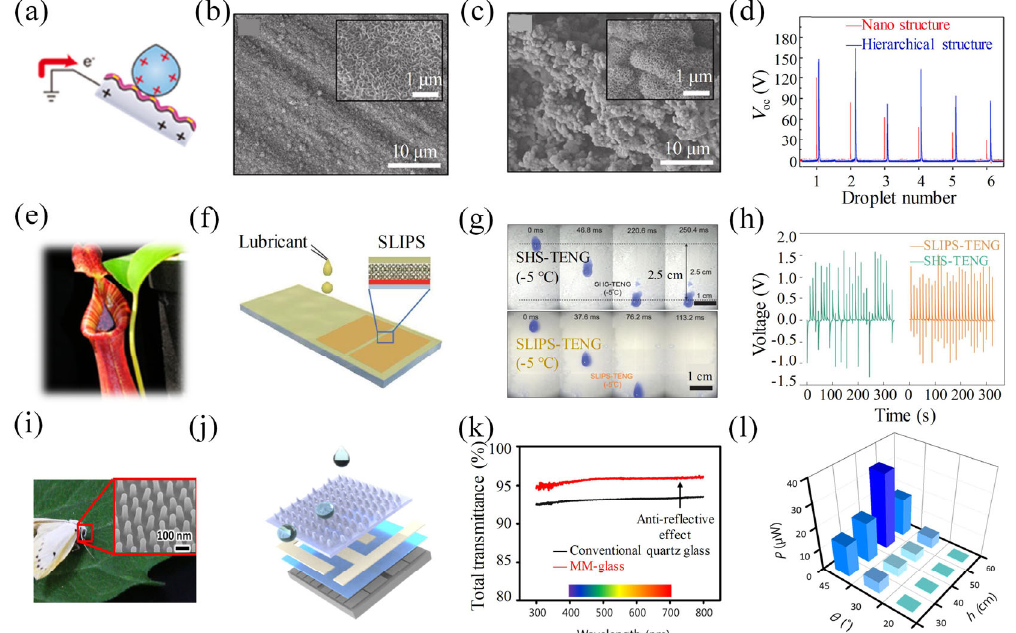
Figure 5 Bio-inspired rainwater-driven electricity generator. (a) Schematic images of a rainwater-driven electricity generator. (b) SEM image of nanostructured superhydrophobic surface of the rainwater-driven electricity generator. (c) SEM image of hierarchically structured superhydrophobic surface of the rainwater-driven electricity generator. (d) Electrical output comparison of a rainwater-driven electricity generator with nanostructured superhydrophobic surface and a rainwater-driven electricity generator with hierarchically structured superhydrophobic surface. (a)–(d) Reproduced with permission from Ref. [114], © Elsevier B.V. 2019. (e) Image of the Nepenthes Pitcher. Reproduced with permission from Ref. [117], © American Chemical Society 2014. (f) SLIPS-based electricity generator. (g) Separation of droplets from different surfaces at low temperatures. (h) Electrical output of the SLIPS-TENG and SHS-TENG. (f)–(h) Reproduced with permission from Ref. [120], © Oxford University Press 2019. (i) SEM image of the moth’s eye. (j) Schematic of the hybrid system with the MM-glass-based TENG and solar cell. (k) Total transmittance of conventional quartz glass and MM-glass at the wavelength ranging from 300 nm to 800 nm. (l) Power of the MM-TENG at different impacting conditions. (i)–(l) Reproduced with permission from Ref. [121], © Elsevier B.V.